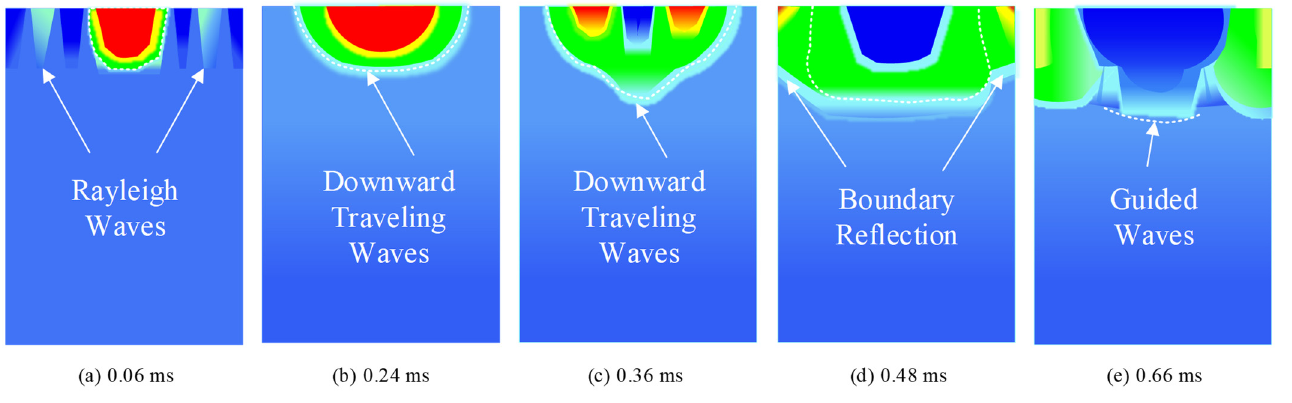
Figure 11. Formation of the high-frequency interference caused by circumferential transverse wave: ( a ) circumferentially propagated Rayleigh wave; ( b ) guided wave (reproduced from Zhang et al. (2022) [82]). 2.4. Progress in Studies Associated with the Pile Group Effect In reality, pile foundations usually appear more in the form of pile groups, while the use of single pile foundation is quite rare [95–97]. During the vibration of pile groups, the impedance of each pile would be influenced by other piles, which is described as the “pile group effect”. To account for this effect, Kaynia and Kausel [98], and Dobry and Gazetas [99] introduced the concept of ‘the dynamic interaction factor